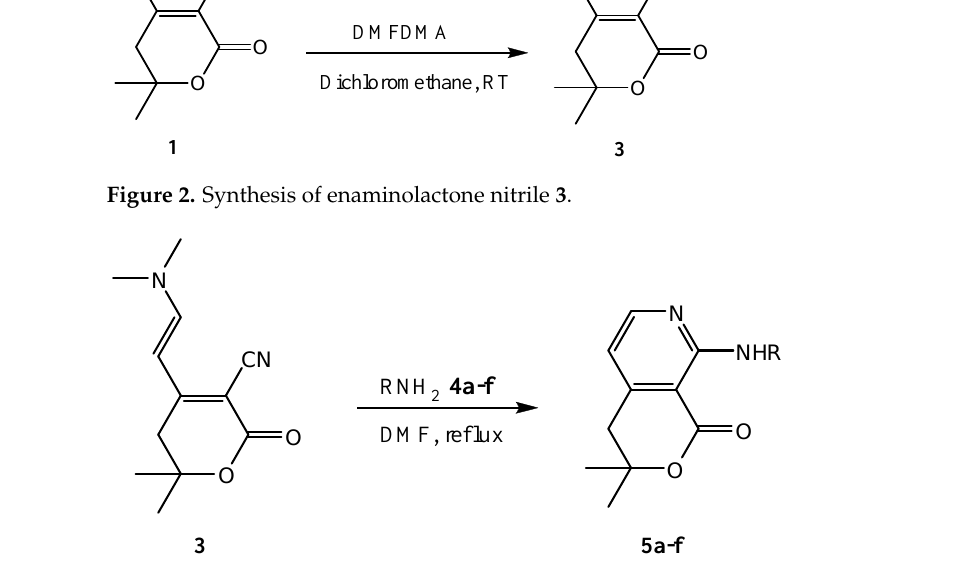
Figure 2. Synthesis of enaminolactone nitrile 3.